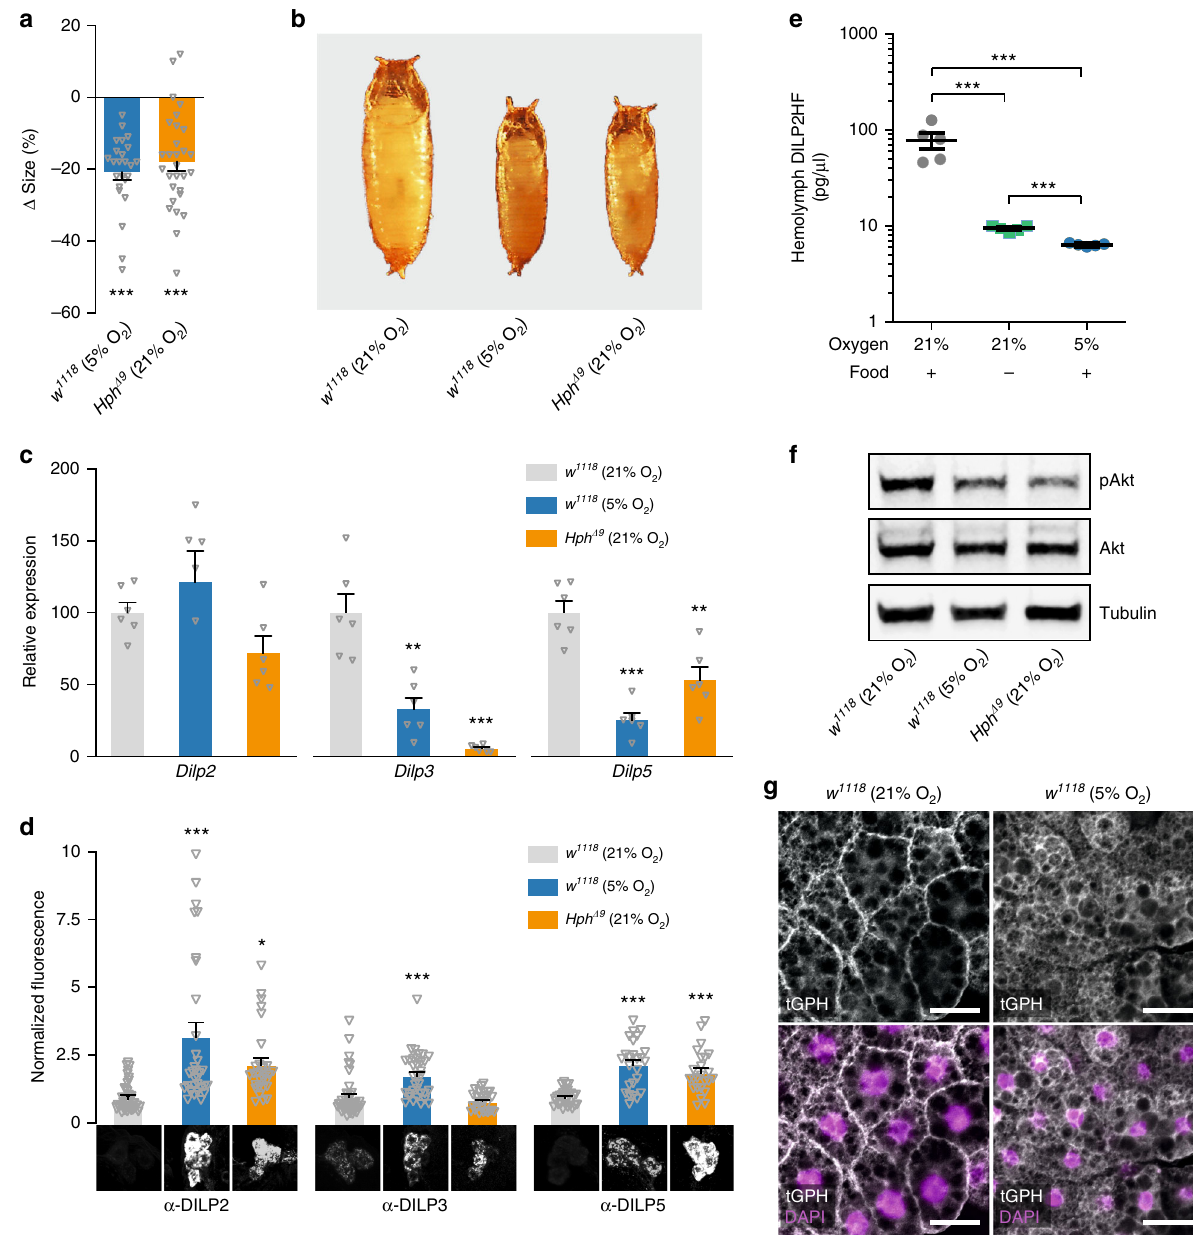
Fig. 5 Hypoxia and induction of hypoxia adaptation block growth and DILP secretion. a , b Quanti fi cation of pupal size ( a ) and representative images ( b ) of animals exposed to hypoxia (5% O 2 ) or mutation of HIF-1a prolyl hydroxylase ( Hph ) compared with controls ( w 1118 in normoxia). Values are percent change in pupal size vs. w 1118 -in-normoxia controls. a : n = 24 – 34. c , d Transcript levels of Dilp genes in whole animals ( c ) and DILP peptide levels ( d ) in the insulin-producing cells (IPCs) of hypoxic wild-types and normoxic Hph mutants compared with normoxic wild types. Representative images of IPC DILP2, -3, and -5 immunostaining are shown below. c : n = 6. d : n = 29 – 42. e Hemolymph HA::DILP2::FLAG (DILP2HF) levels in normoxic (21% O 2 , on normal food), hypoxic (5% O 2 ; normal food), and starved (21% O 2 ; 1% agar) animals determined by ELISA. n = 5. f Immunoblotting shows that levels of phosphorylated Akt (pAkt) is reduced under hypoxia and in Hph mutants compared with btl > + controls when normalized to alpha-Tubulin (Tub) or total Akt levels. g tGPH reporter of insulin signaling con fi rms that hypoxia reduces systemic insulin signaling in peripheral tissues, represented here by the fat body. Under conditions of normal insulin activity (e.g., fed normoxia, left), the tGPH sensor is localized to the plasma membrane, whereas under conditions of low signaling (e.g., fed hypoxia, right) the sensor becomes primarily cytoplasmic. Scale bar, 20 µ m. Statistics: one-way ANOVA with Dunnett ’ s multiple- comparisons test. * P < 0.05, ** P < 0.01, *** P < 0.001, compared with the control. Error bars indicate SEM. Underlying data are provided in the Source Data fat bodies for 16 h ex vivo under normoxia or hypoxia and assessed fat bodies, however, did exhibit reduced Dilp expression under the insulin-related effects of these manipulations (Fig. 6c). Whereas hypoxia compared with normoxic cultures. These observations hypoxic larvae exhibit reduced Dilp3 and -5 expression (Fig. 5c), we demonstrate that the brain alone is insuf fi cient for hypoxia adap- observed no decrease in insulin-gene expression in brains cultured tation, and that a humoral signal(s) from the fat body regulates alone under hypoxia vs. normoxia (Fig. 6d). Brains co-cultured with Dilp3 and -5 expression as part of this response.